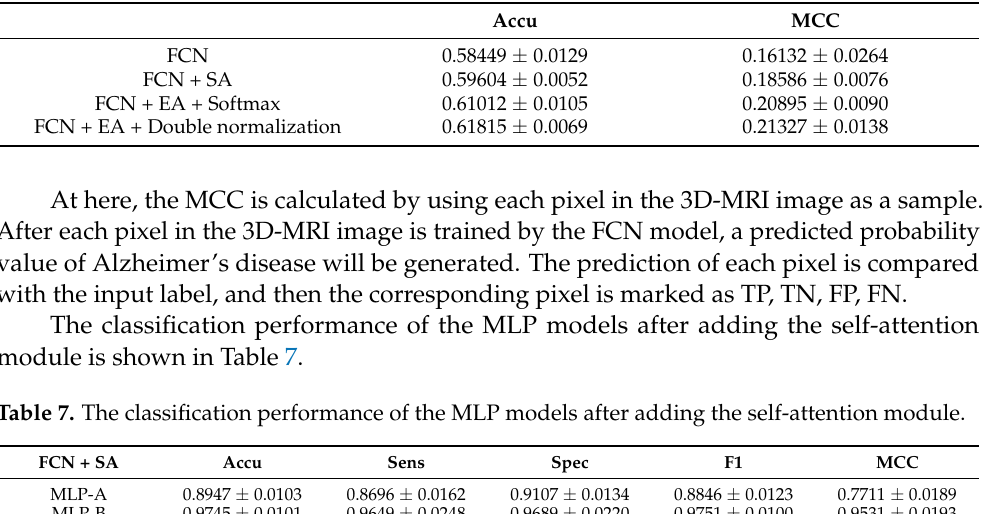
Table 6. The classification performance of the FCN model.